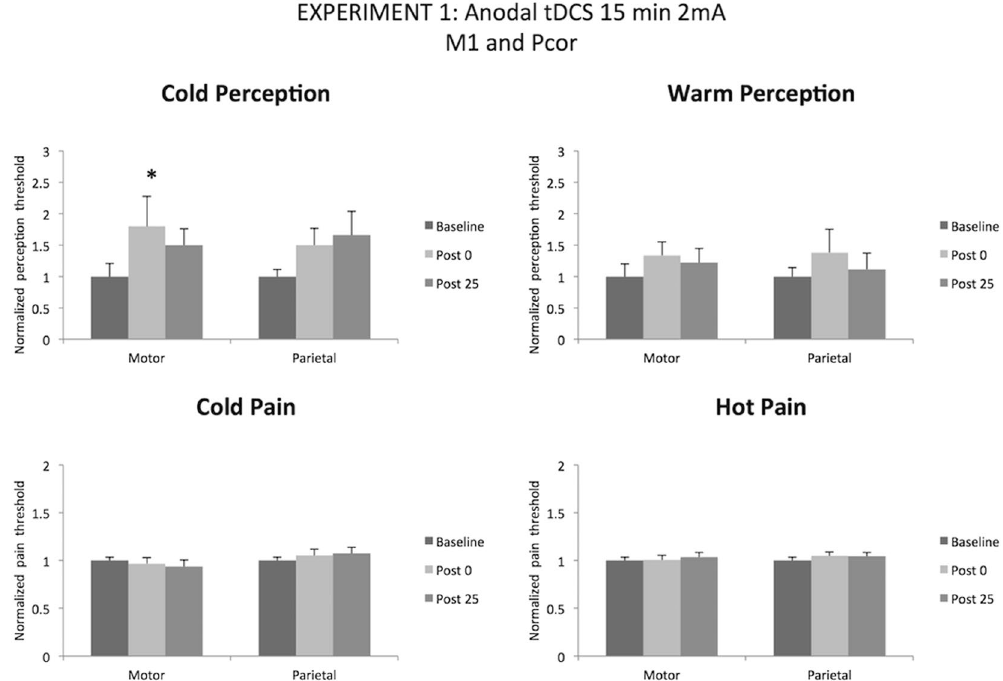
Figure 3. Temperature perception thresholds and pain thresholds for warm (hot) and cold perception (Anodal tDCS 15 min 2 mA over motor and sensory cortex). Error bars are standard deviations. * p < 0.05.